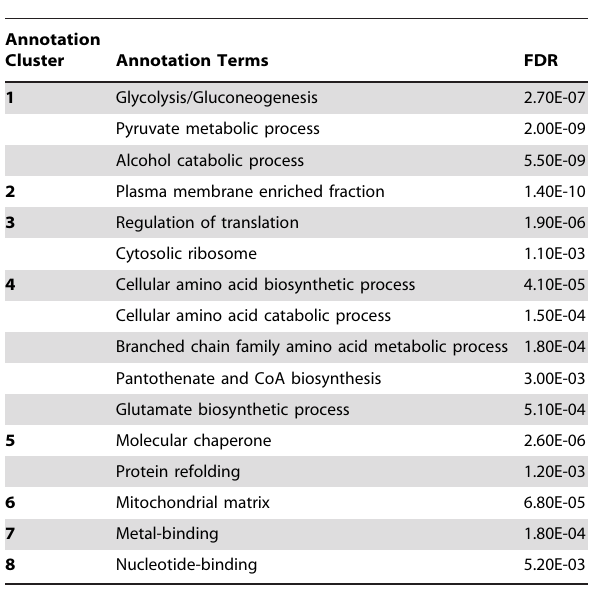
Table 2. Functional annotation enrichment analysis of the identified proteins using the Database for Annotation, Visualization and Integrated Discovery (DAVID )